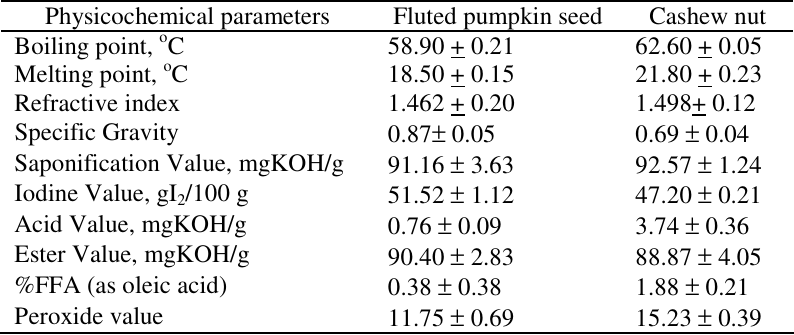
Table 1. Physicochemical parameters of the oil